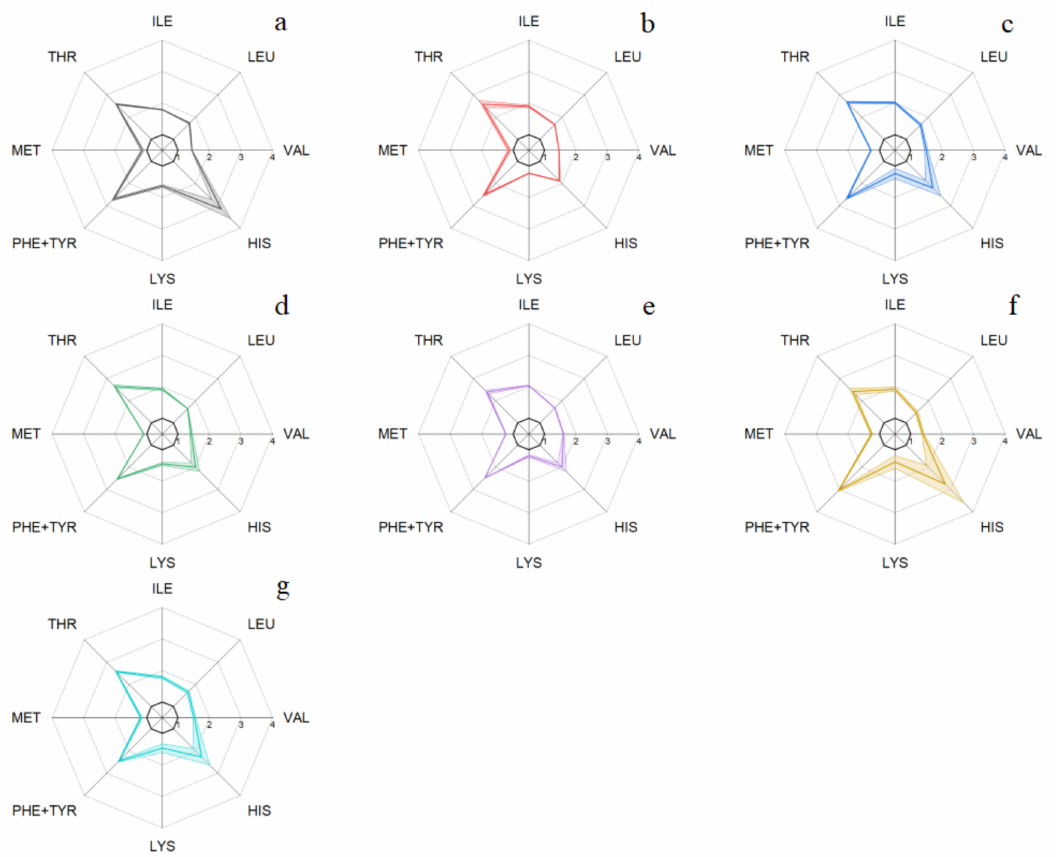
Figure 5. Amino acid profile for each treatment in the mixotrophic experiment. ( a ) NaHCO 3 ; ( b ) Lactose; ( c ) Glucose; ( d ) Galactose; ( e ) Fructose; ( f ) Glycerol; ( g ) Maltose. ILE—Isoleucine; LEU—Leucine; VAL—Valine; HIS—Histidine; LYS—Lysine; PHE + TYR—Phenylalanine + Tyrosine; MET—Methionine; THR—Threonine. FAO/WHO individual EAAI threshold is represented as